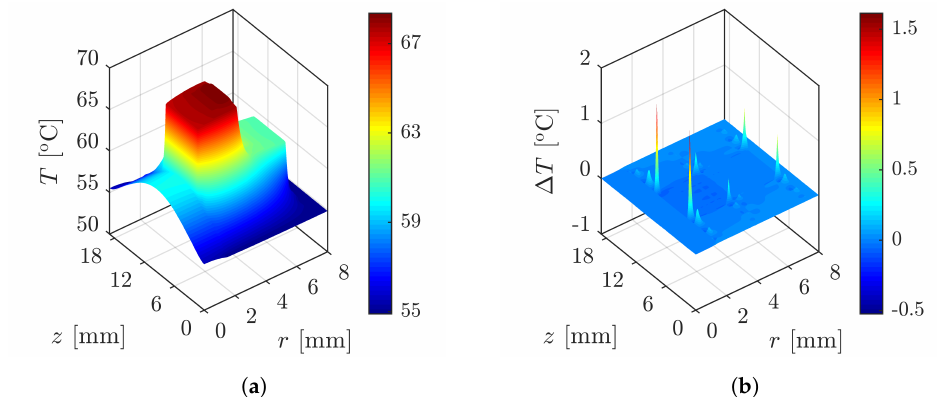
Figure 7. Temperature distribution ( a ) obtained with the SEM. The difference with respect to the FEM solution is shown in ( b ).